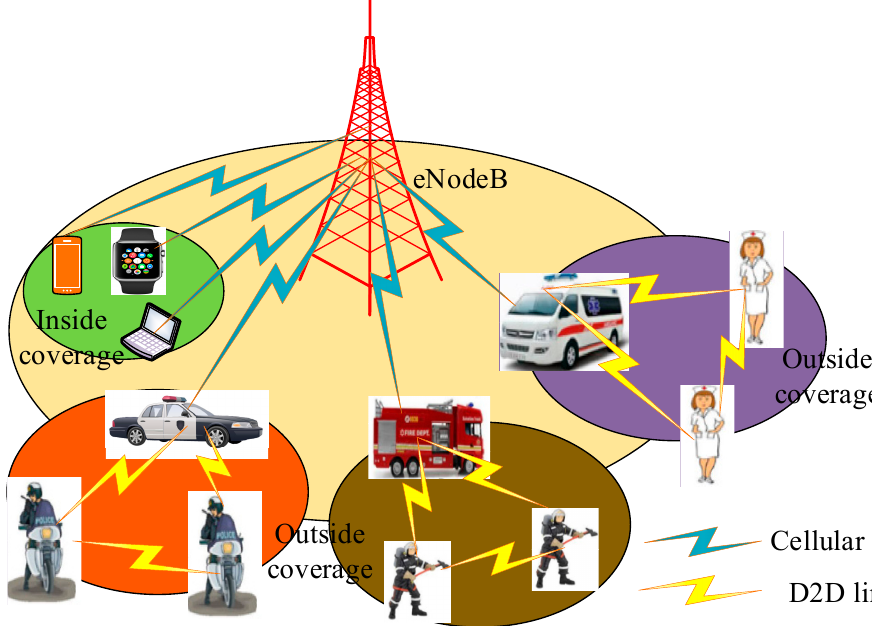
Figure 1. The application of a D2D communication scenario over IoT-based 5G networks.